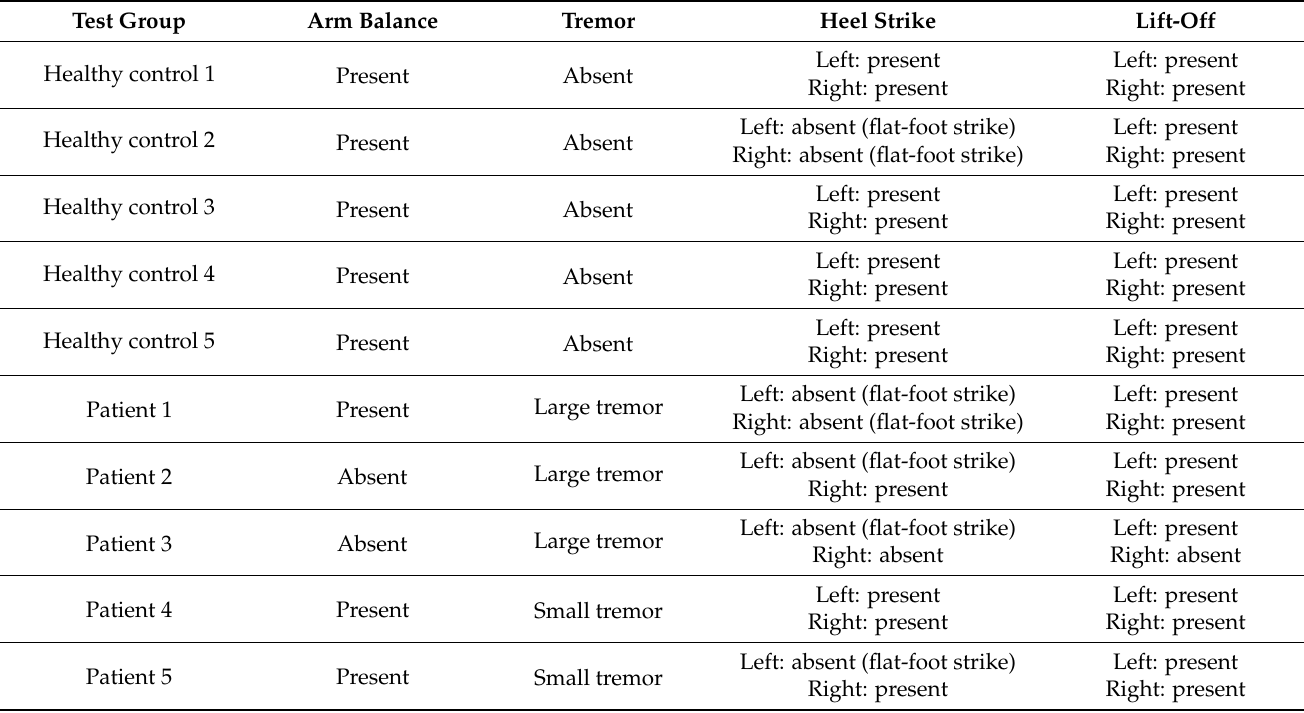
Table 2. Biomechanical parameters of the test